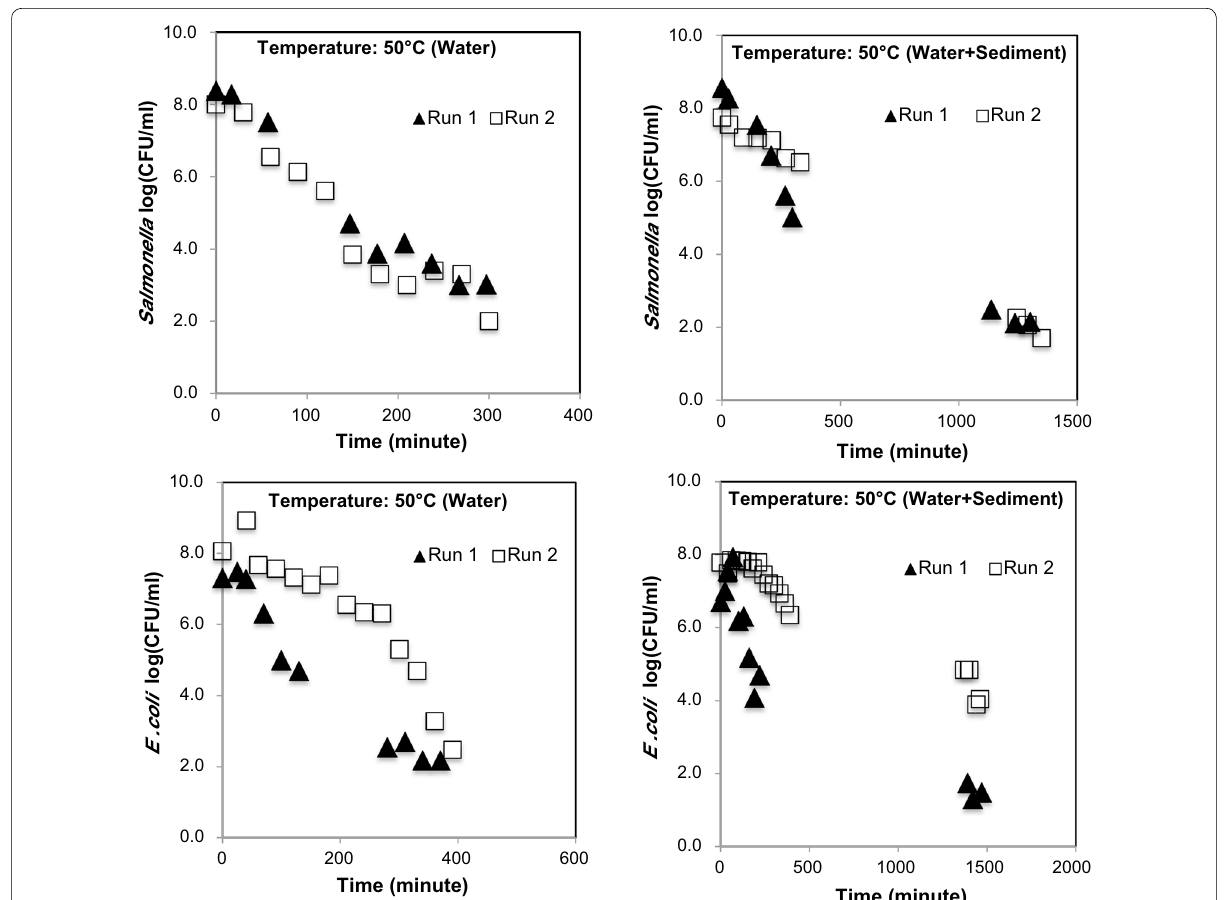
Fig. 5 Survival of Salmonella and E. coli O157:H7 and at 50 °C (thermophilic temperature) in free floating and particle attached